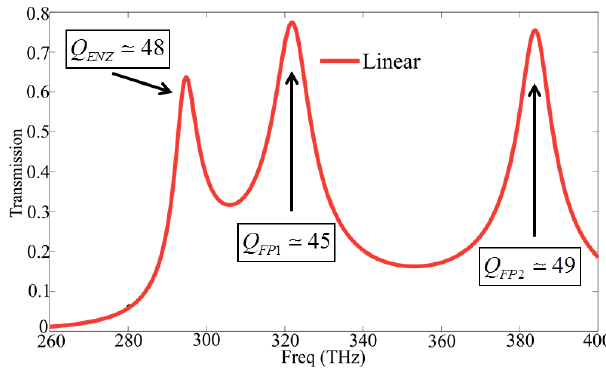
Figure 3: Transmission coefficient versus frequency for linear material loaded in the slits shown in Fig. 1. Three distinct resonances (ENZ, FP 1, FP 2) exist with almost similar, relative low, Q-factors.